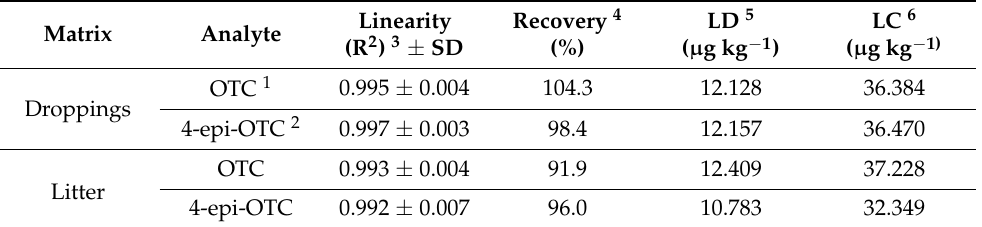
Table 1. Validation parameters for droppings and litter.